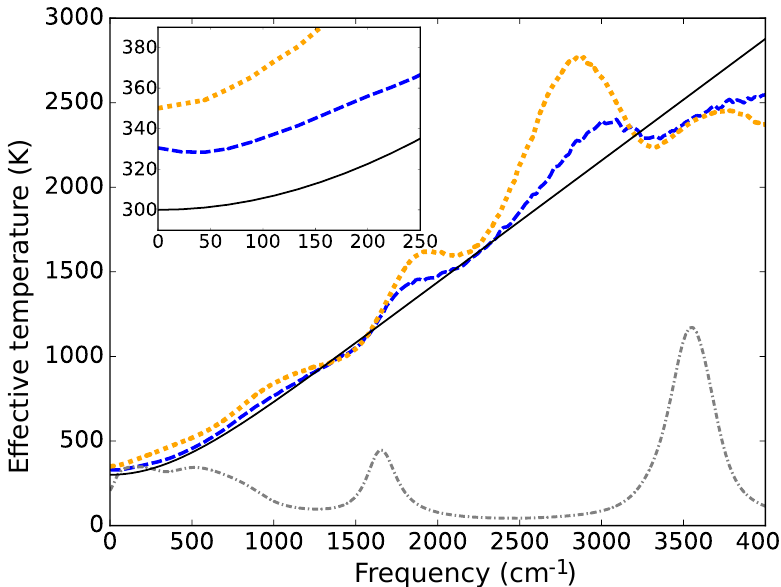
Figure 11. Effective temperature T eff versus frequency as defined by Equation (33) in liquid water at 300 K described with the q-TIP4P/F model and simulated with the QTB method using γ = 20 ps − 1 . The blue dashed line corresponds to oxygen (it is average over all O atoms and over all three directions x , y and z ), the dotted orange line to hydrogen, and the black continuous line is the θ ( ω , T ) that corresponds to the first-kind FDT. The simulations were performed using reference k − 1 B Tinker-HP software [81] and parameters similar to that in Ref. [18]. The inset represents a zoom on the low-frequency region and the vibrational power spectrum mC vv ( ω ) is shown as a dashed-dotted grey line.